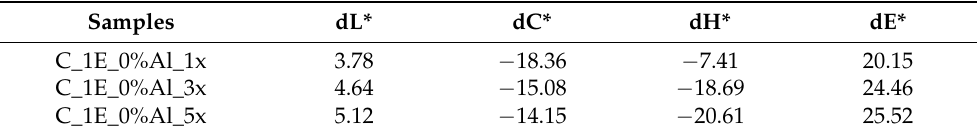
Table 8. Change in color coordinates of cotton samples dyed with SJL aqueous extract without mordants after 1st, 3rd and 5th washing cycle (compared with C_1E_0%Al_0x).